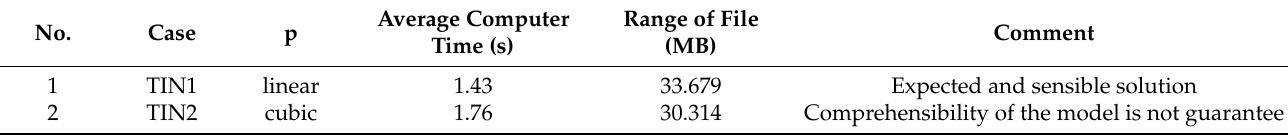
Table 3. Results of TIN